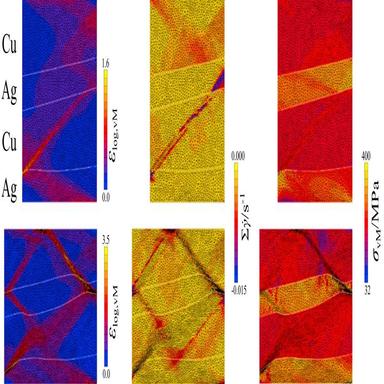
Simulation results of equivalent logarithmic strain, sum of shear rates on the shear band systems and equivalent CAUCHY stress for the Copper-Silver bicrystal at 20% (top) and 40% (bottom) thickness reductions. Figure adopted from with permission from Elsevier.